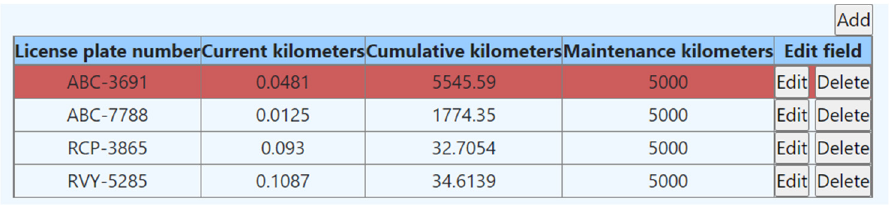
Figure 39. Vehicle management menu.